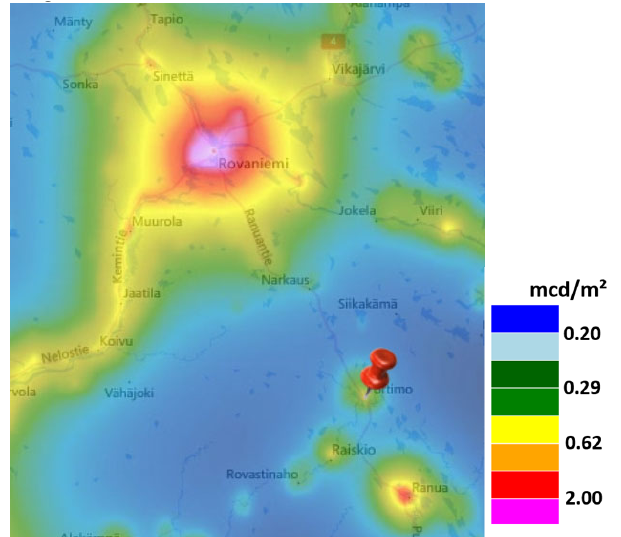
Figure 2. Map of the remote subarctic site in Portimo (arrow) near the city of Rovaniemi, Finland using data from the world atlas of artificial night sky brightness [1] (source: lightpollutionmap.info by Jurij Stare).